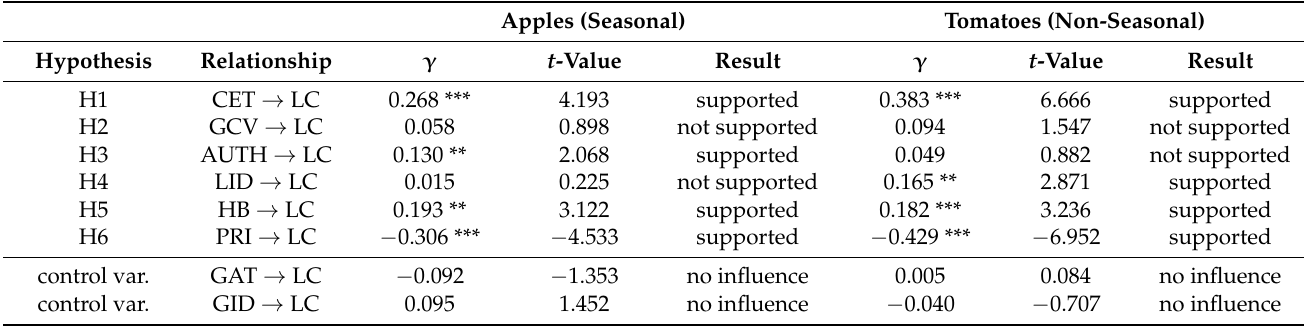
Table 7. Structural model parameter estimates for the seasonal consumption model and for the non-seasonal consumption model (H1–H6). Apples (Seasonal) Tomatoes